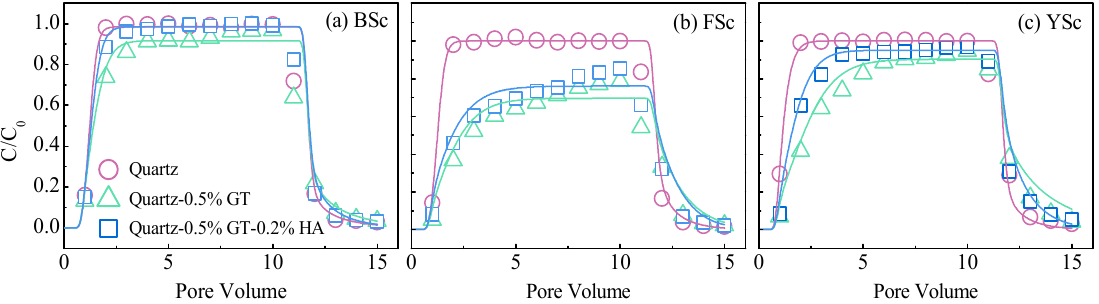
Figure 2. Breakthrough curves of ( a ) black soil colloids (BSc), ( b ) fluvo-aquic soil colloids (FSc), and ( c ) yellow soil colloids (YSc) in the quartz sand column (purple circles), 0.5% GT mixed sand column (green triangles), and 0.5% GT and 0.2% HA sand column (blue squares) at pH 7.0.